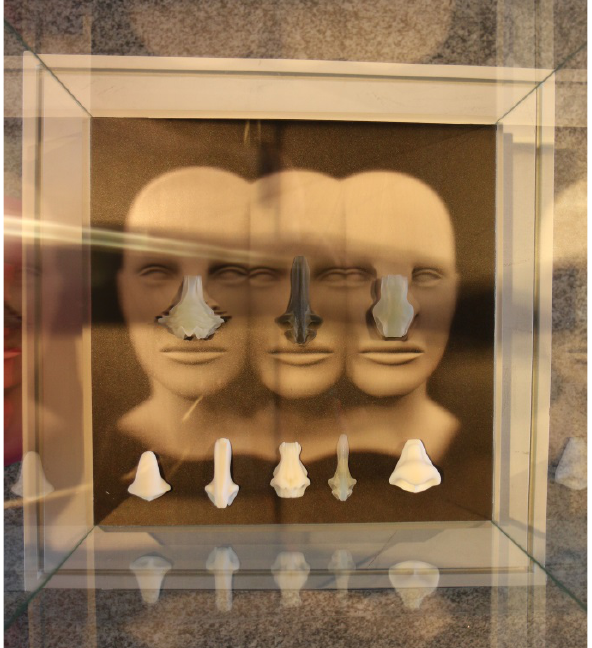
Figure 11 | Marta Flisykowska, Who Nose? , Museo del Traje,